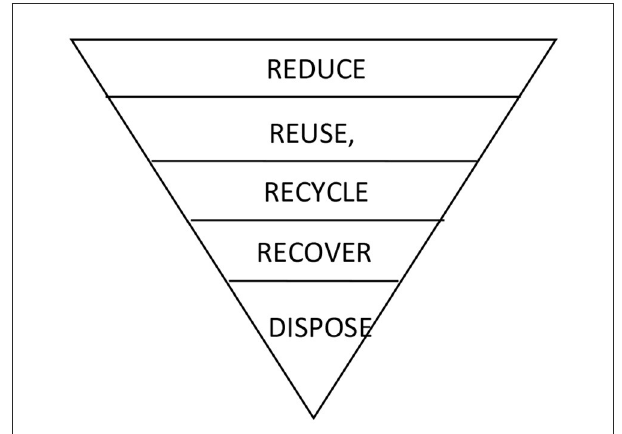
FIGURE3 Hierarchy of waste management. Source: Adapted from Grant et al. (2017, p.